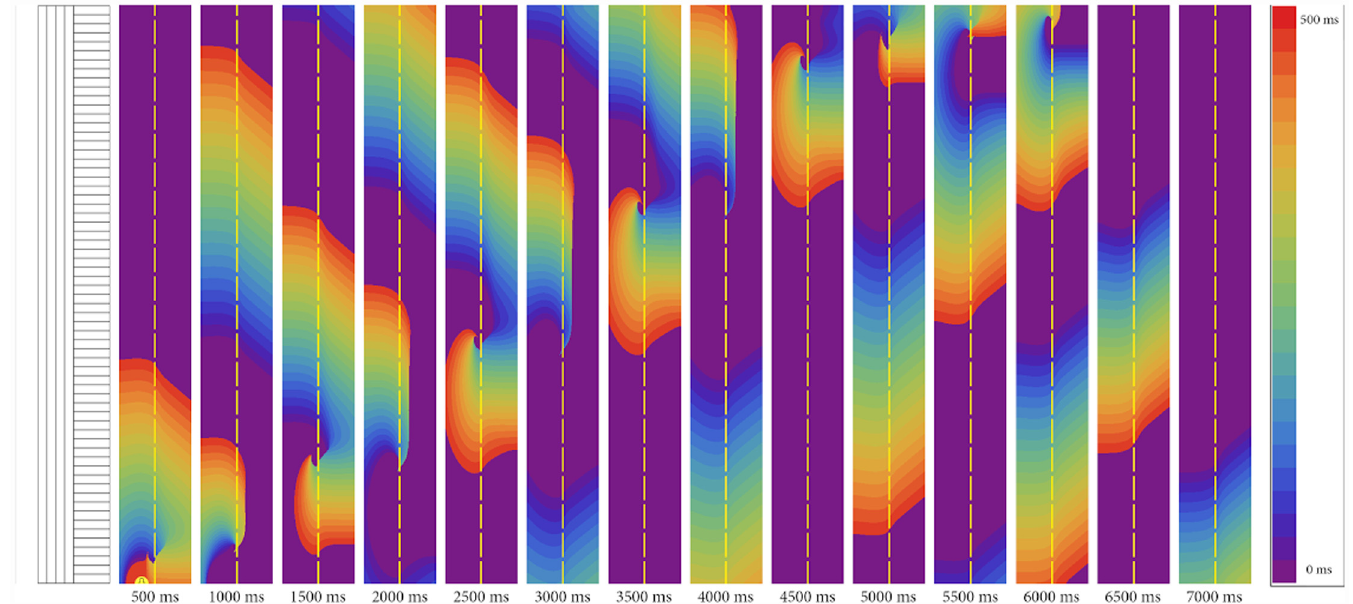
Fig 9. Drift of the reentry. The same simulation as in Fig 8. Size of the tissue: 25.6 cm x 3.2 cm.